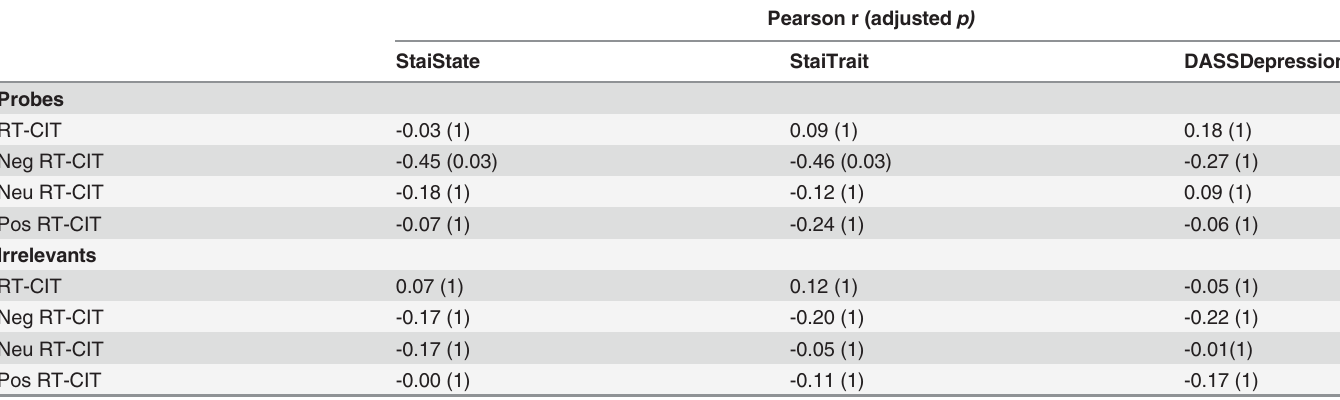
Table 2. Adjusted multiple correlations between anxiety, depression and deception measures: RTs to probes and